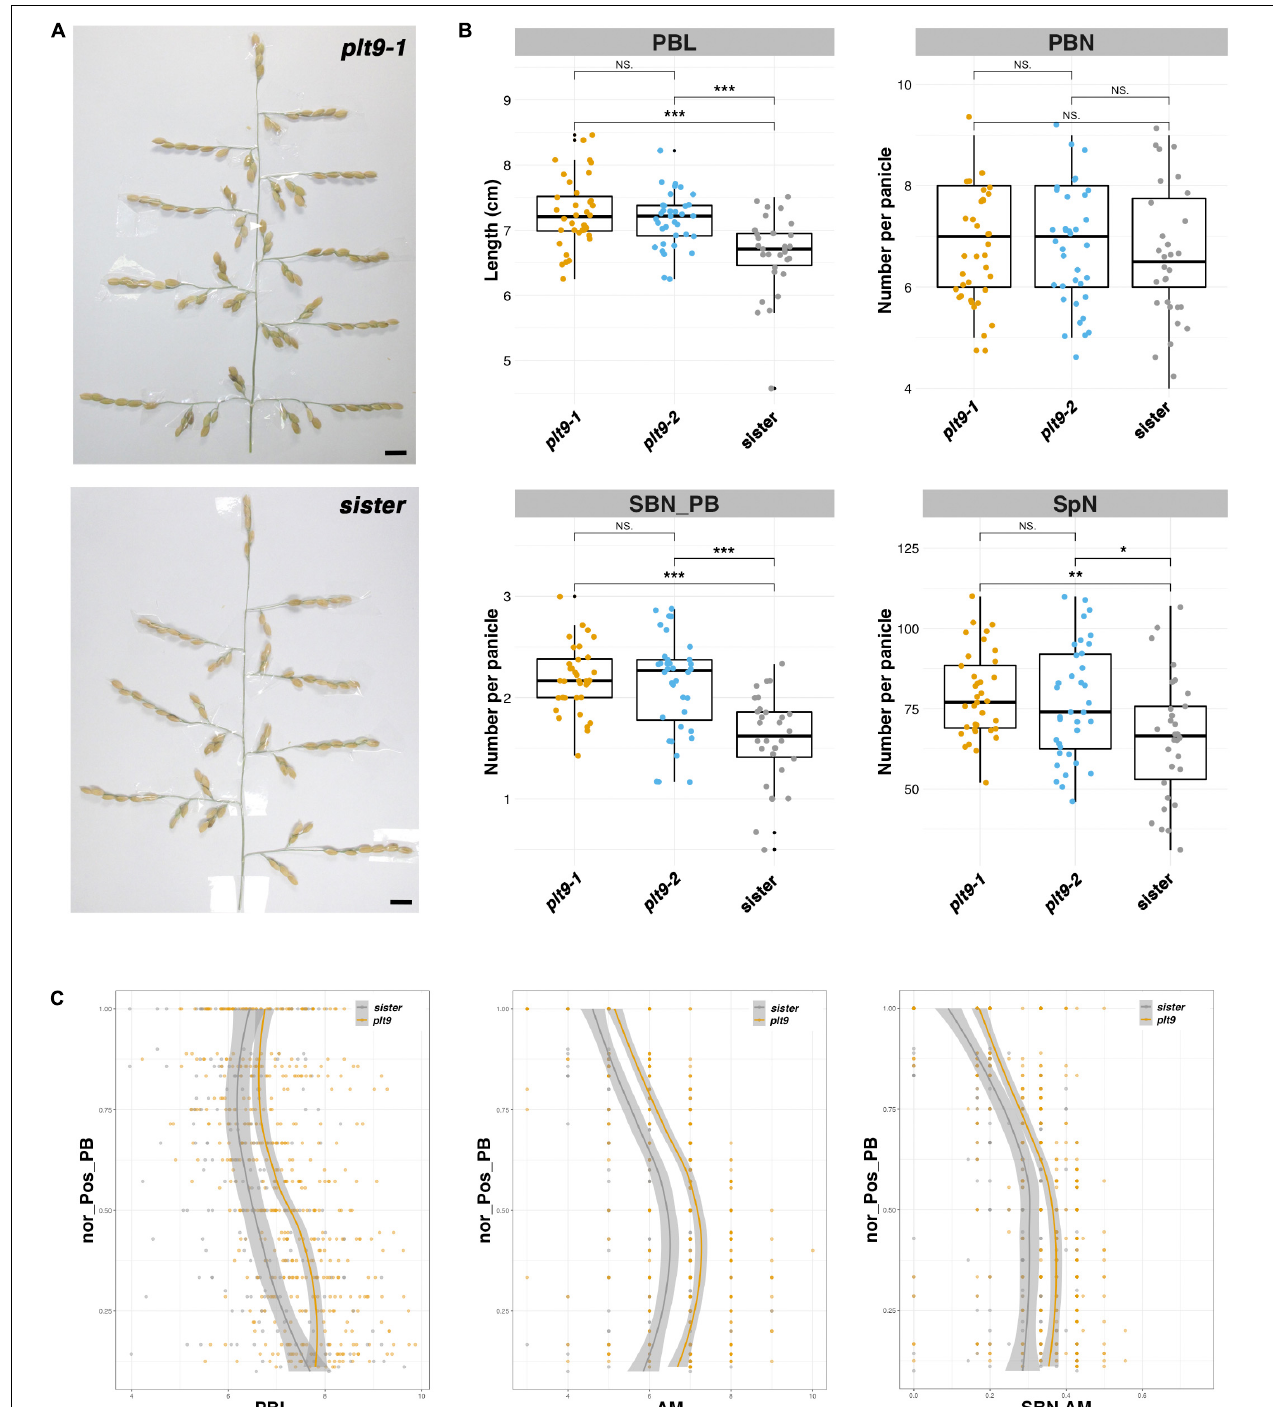
FIGURE 4 | Panicle phenotype of the plt9 mutant. (A) Mature panicles from the CRISPR-Cas9-derived plt9-1 line and a sister (i.e., transgenic plant without mutation). Scale bar: 1 cm. (B) Box plots with individual dots indicating the average primary branch length (PBL), the number of primary branches (PBN), the ratio between secondary branch number and PBN (SBN_PB), and the spikelet number (SpN) per panicle of the CRISPR-Cas9-derived lines, in comparison with sister plants. Individual dots in box plots correspond to average values from the three main panicles per plant. Statistical significance ( t -test p -values) between the two lines or parents for the two panicle morphological traits is indicated as follows: NS if the test is non-significant; * p -values < 0.05; ** < 0.01; *** < 0.001. (C) Plots of normalized position of primary branch (Nor_pos_PB) against PBL, axillary meristem number per PB (AM), and the ratio of SBN vs. AM per PB (SBN.AM). The values of the plt9-1 and plt9-2 lines were pooled together as plt9 .